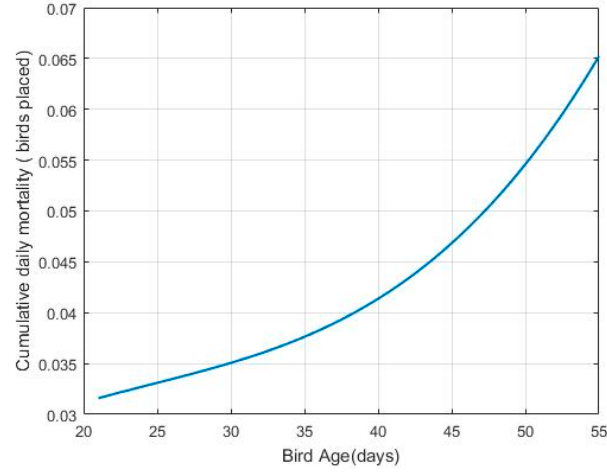
Figure 3. Feed consumption curve.